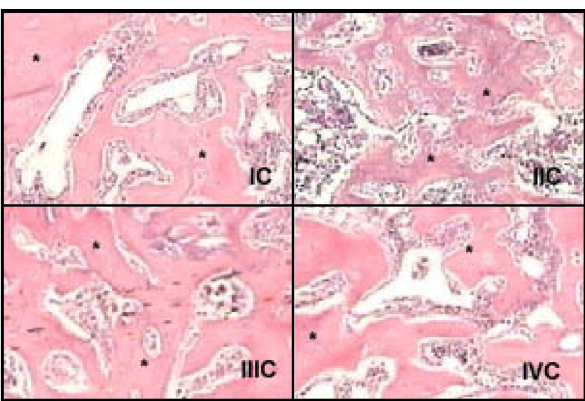
FIGURE 3 - Photomicrographies showing the trabecular formation (*) in the defect areas under light microscopy. Follow-up 21 days.